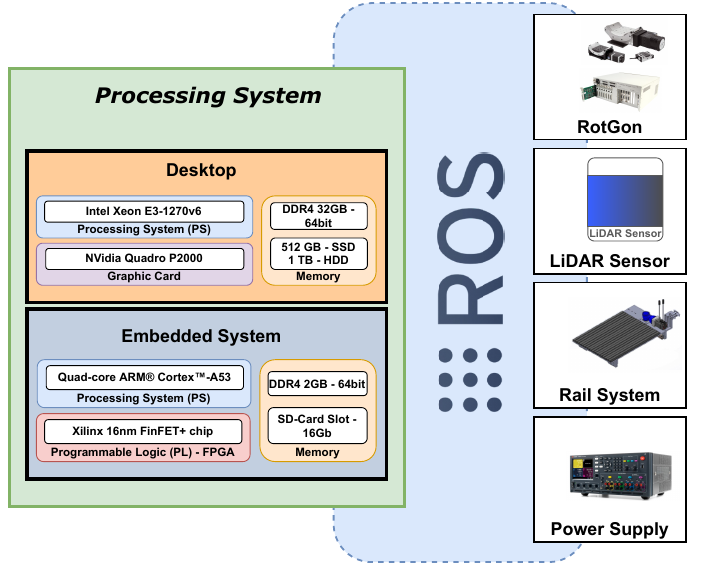
Figure 5. System